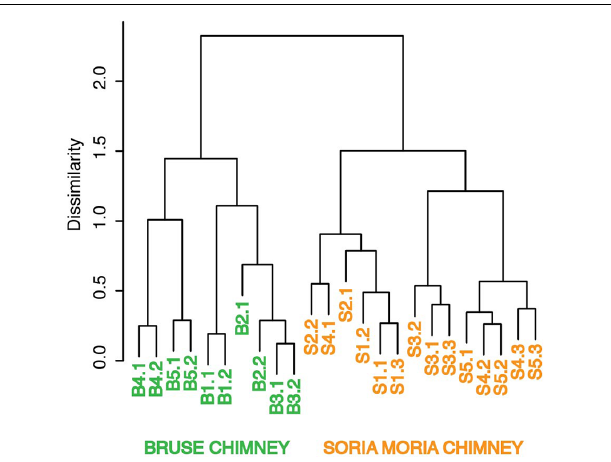
FIGURE 3 | Ward’s minimum variance clustering of samples from Soria Moria- and Bruse chimney walls. Clustering was based on Bray-Curtis distances of relative abundances of OTUs. Sample names correspond to the short names given in Table 1